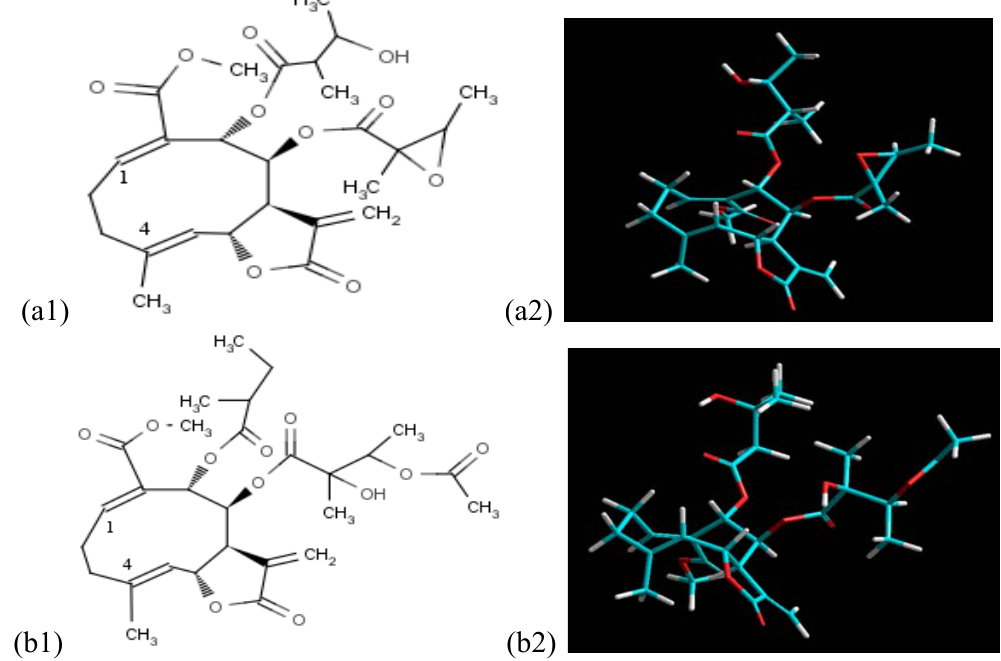
Figure 2. Structures in 2D (two dimensions) of 2 melampolides teraludin I (a1)